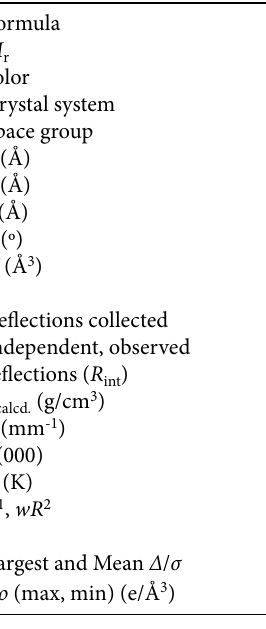
Table 1. Crystal data of 1 .